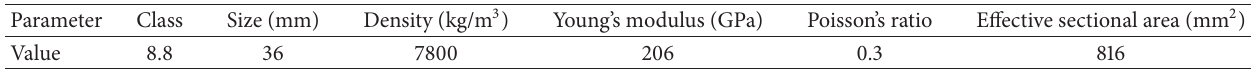
Table 2: Material properties for joint